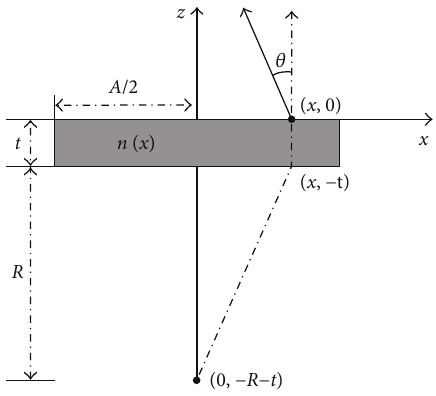
Figure 4: Schematic of the gradient refractive index structure.